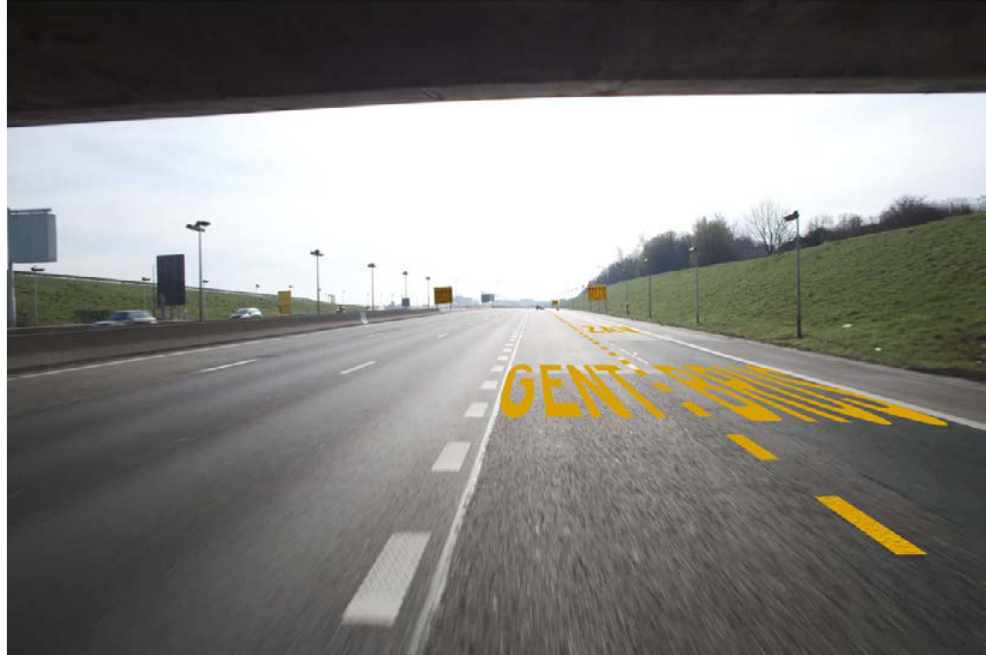
Figure 9. Temporary pavement markings with destination names.